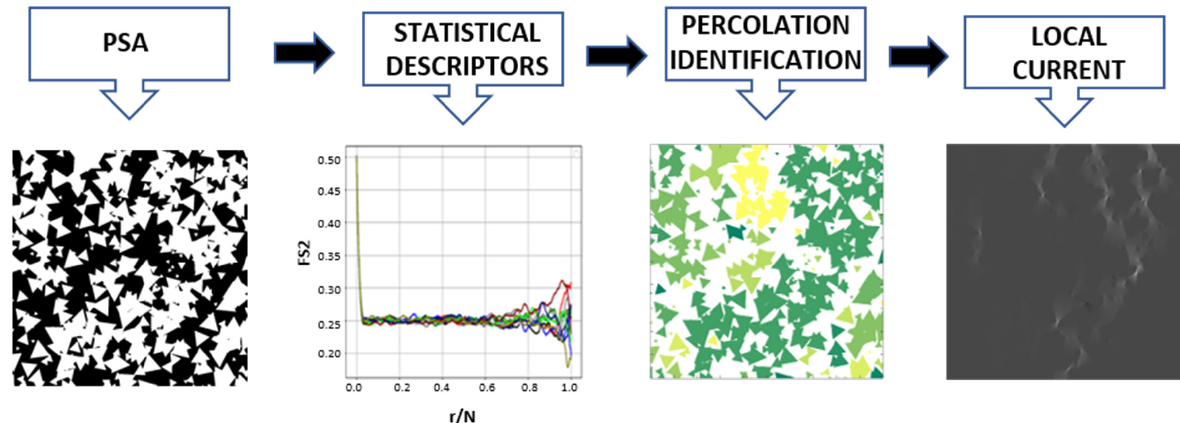
Figure 1. Methodology scheme.